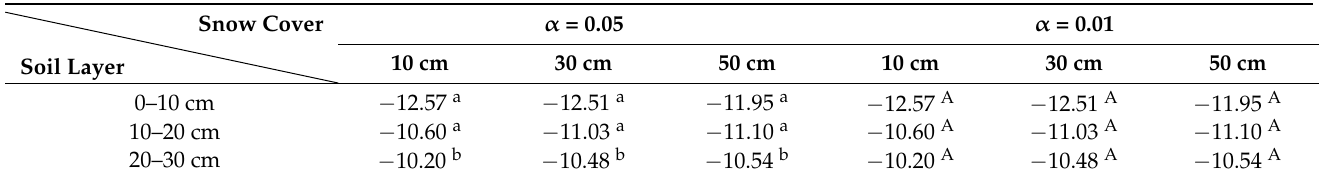
Letters represent differences between groups. With the same letter represent no difference between groups, otherwise, there is a difference. Table 5. Differences in the isotope values of the soil water in the different soil layers for the same depth.